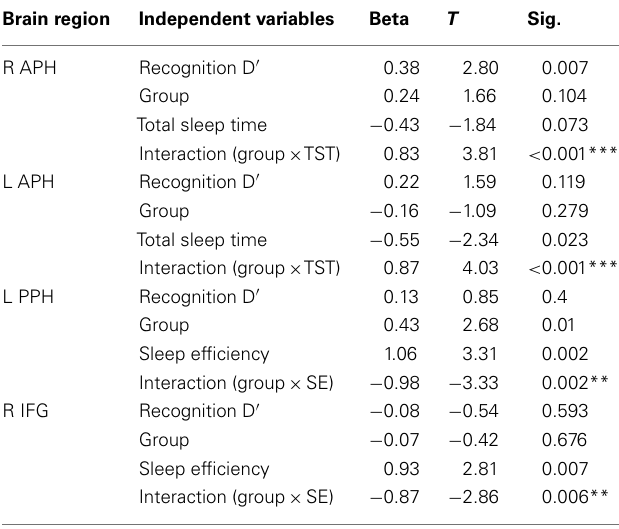
Table 6 | Statistical results of fMRI regression models.